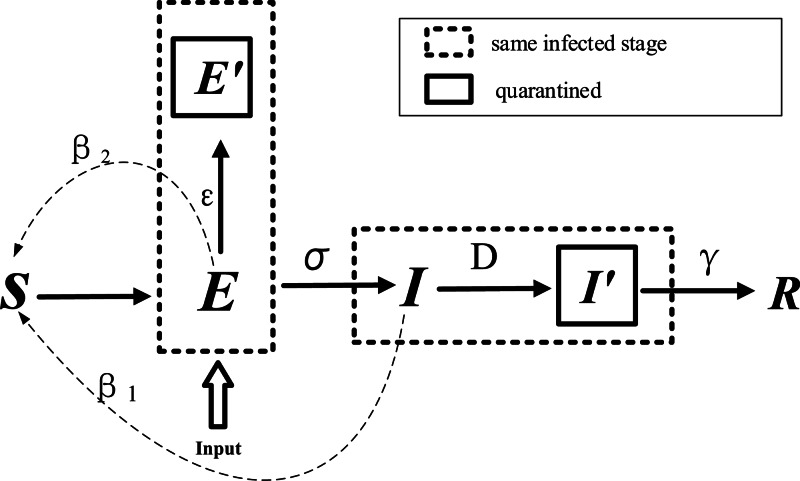
Modified SEIR model for COVID-19.